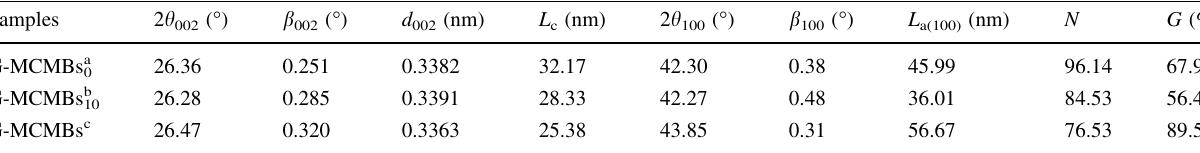
Table 9 Microstructure parameters of MCMBs Samples